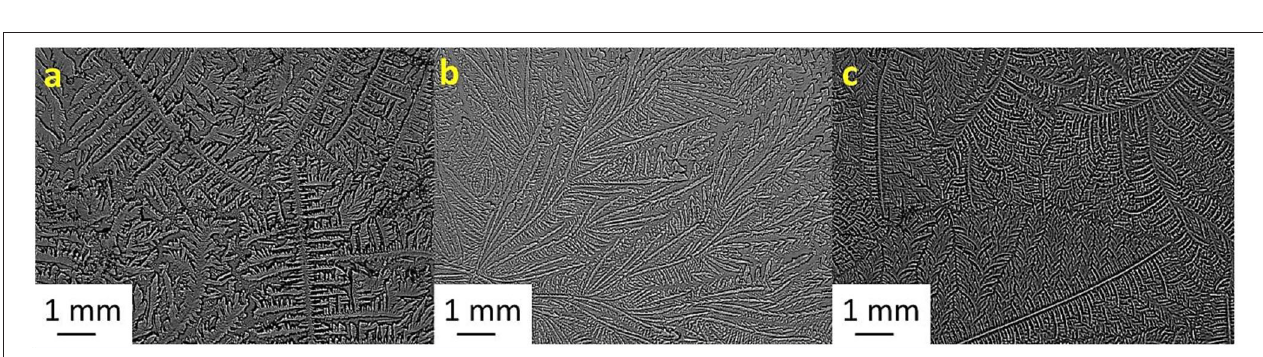
FIGURE 3 | Tear ferning patterns of (a) S3, (b) S3:NaCl (1:10), and (c) S3:MgCl 2 .6H 2 O (1:2). S3, third sheep tear